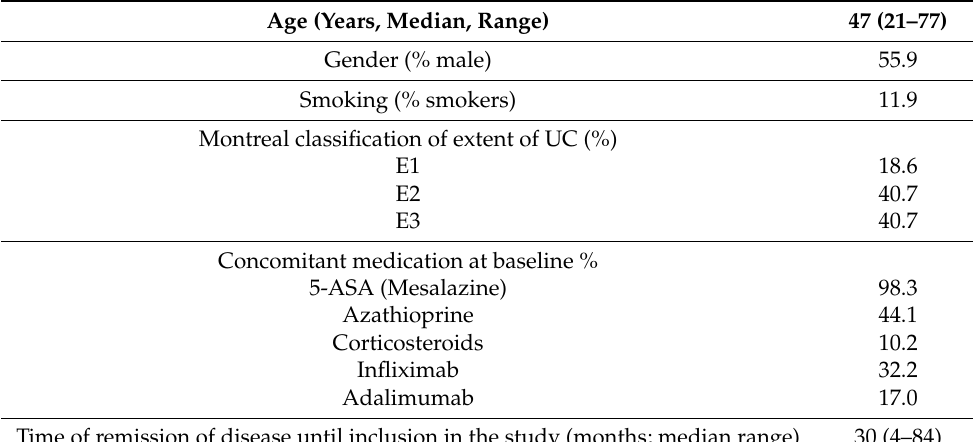
Table 1. Socio-demographic and clinical characteristics of patients at the